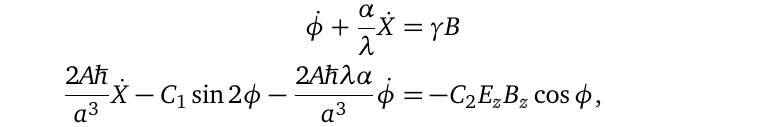
as a function of the electric field E 0 = B = 0, and B < 0 for parameter values 3 . , and where B y x z y | = 1 T, the dashed line corresponds to | B y | = y